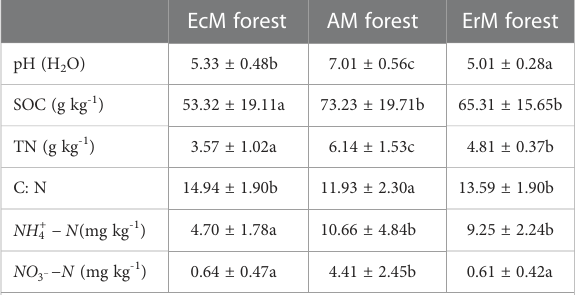
TABLE 1 Soil properties among three mycorrhizal forests (values are the means ± 1SE, n = 56).